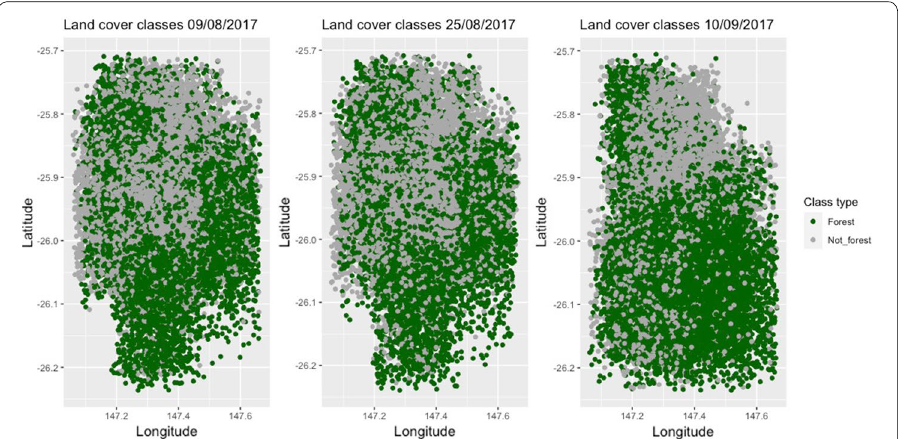
Fig. 13 Plot of the true land cover classifications for the same sample of pixels in Area 1 across three time points, plotted by their latitude and longitude. The points are jittered by 0.1 to make interpretation easier as they are spatially close together. Forest is shown in green and not forest in